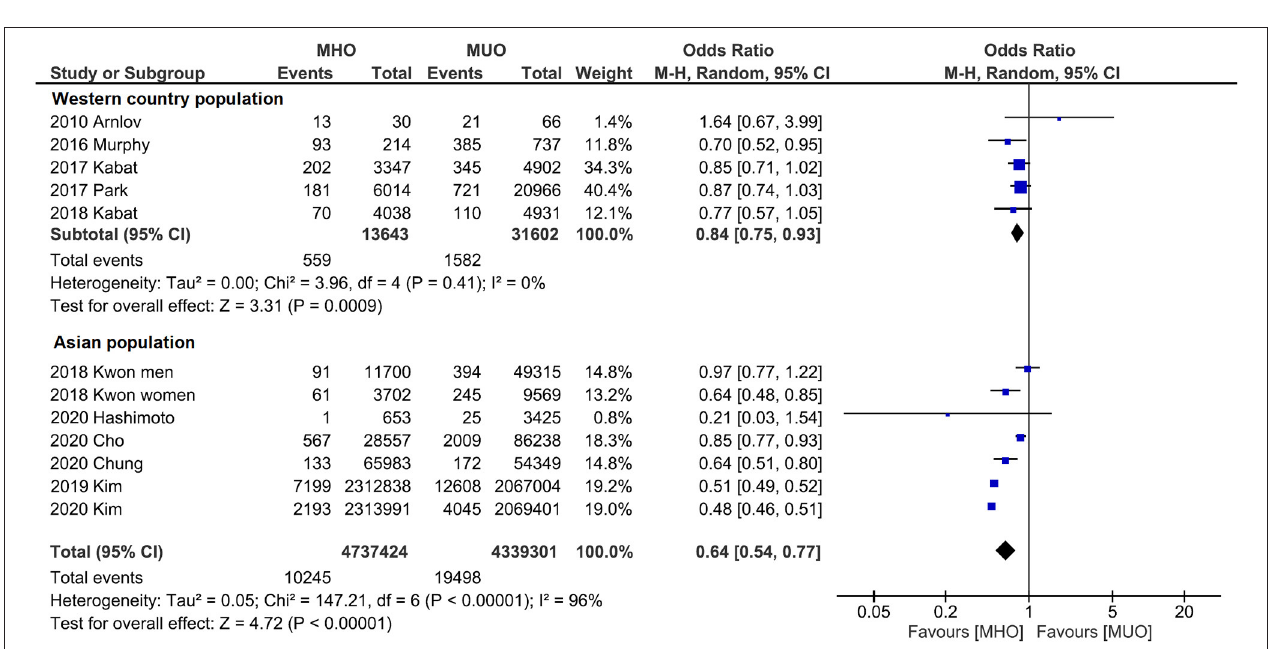
FIGURE 4 | Subgroup analysis grouped by the region of cohorts. Lower cancer incidence for metabolically healthy obesity phenotype is found in both western population and Asian population.